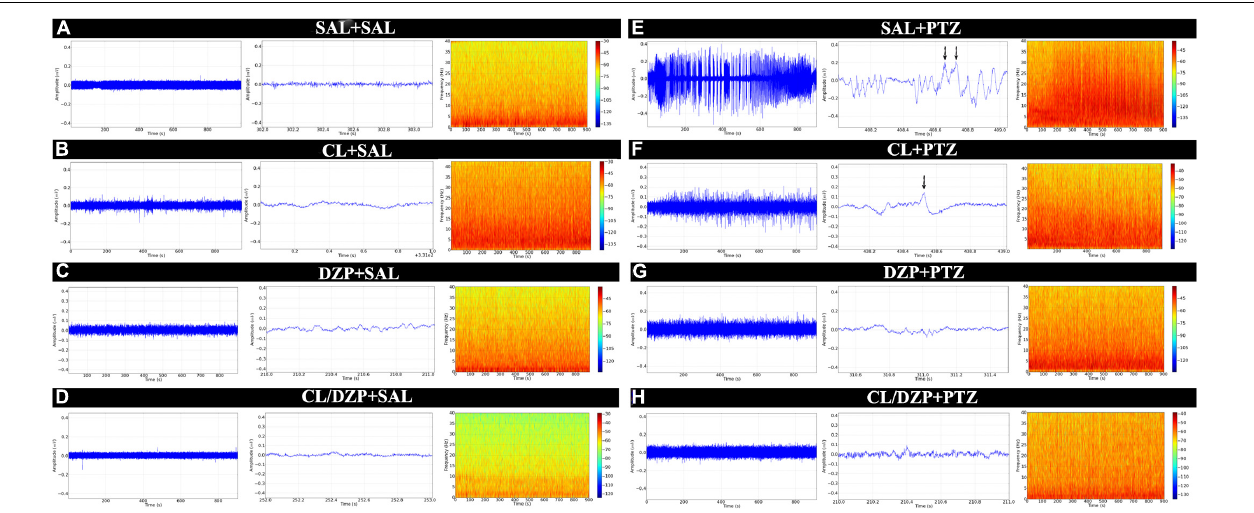
FIGURE 2 | Electroencephalographic recordings of animals submitted to the PTZ-induced seizure model and treated with Curcuma longa and/or diazepam. The linear trace was obtained by electroencephalography (left). Representative 1 s sequence of the EEG trace (center). Spectrogram frequency (right). (A) Animals that received no treatment (SAL-SAL). (B) Animals pretreated with Curcuma longa but not injected with PTZ (CL-SAL). (C) Animals pretreated with diazepam but not injected with PTZ (DZP-SAL). (D) Animals pretreated with Curcuma longa + diazepam not injected with PTZ (CL/DZP-SAL). (E) Animals pretreated with saline and injected with PTZ (SAL-PTZ). (F) Animals pretreated with Curcuma longa and injected with PTZ (CL-SAL). (G) Animals pretreated with diazepam and injected with PTZ (DZP-PTZ). (H) Animals pretreated with Curcuma longa + diazepam and injected with PTZ (CL/DPZ-PTZ). SAL, saline; CL, Curcuma longa ; DZP, diazepam; PTZ,